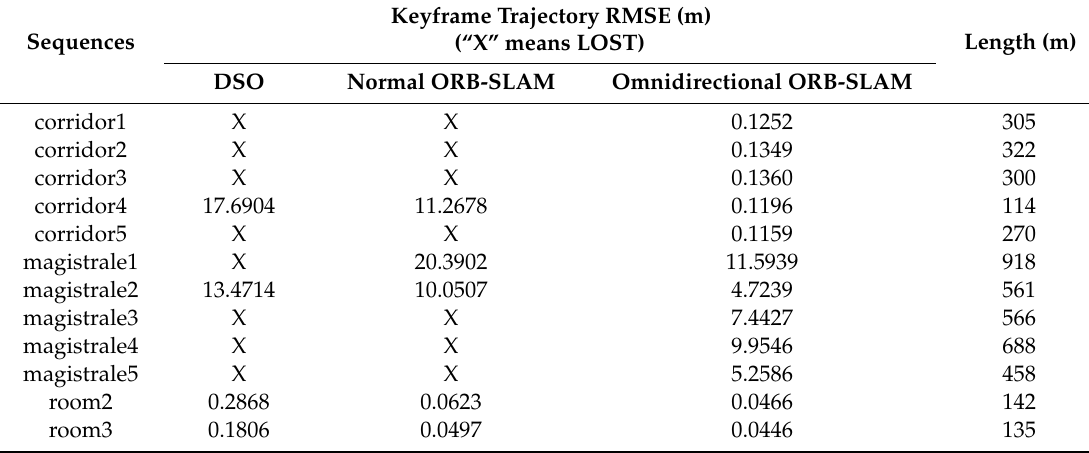
Table 1. Comparison of translation root mean square error (RMSE). DSO = direct sparse odometry.